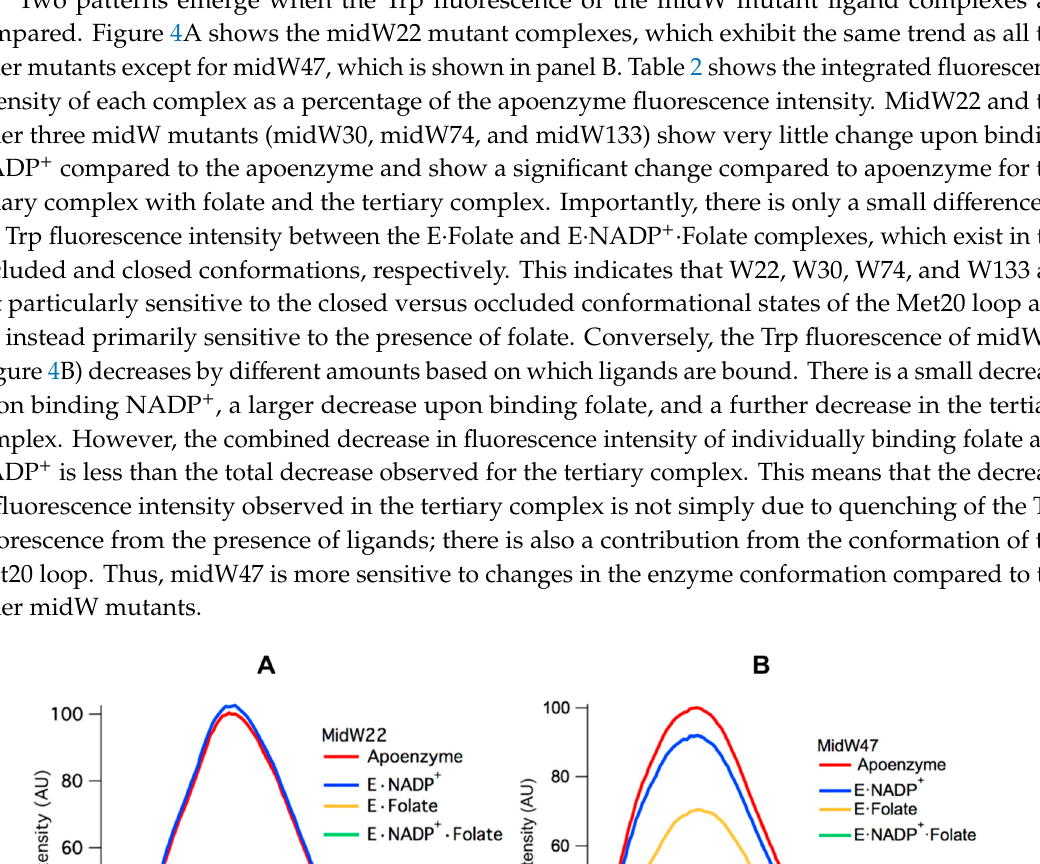
Table 2. Integrated Trp fluorescence intensity of the enzyme–ligand complexes as a percentage of the integrated Trp fluorescence intensity of the apoenzyme.